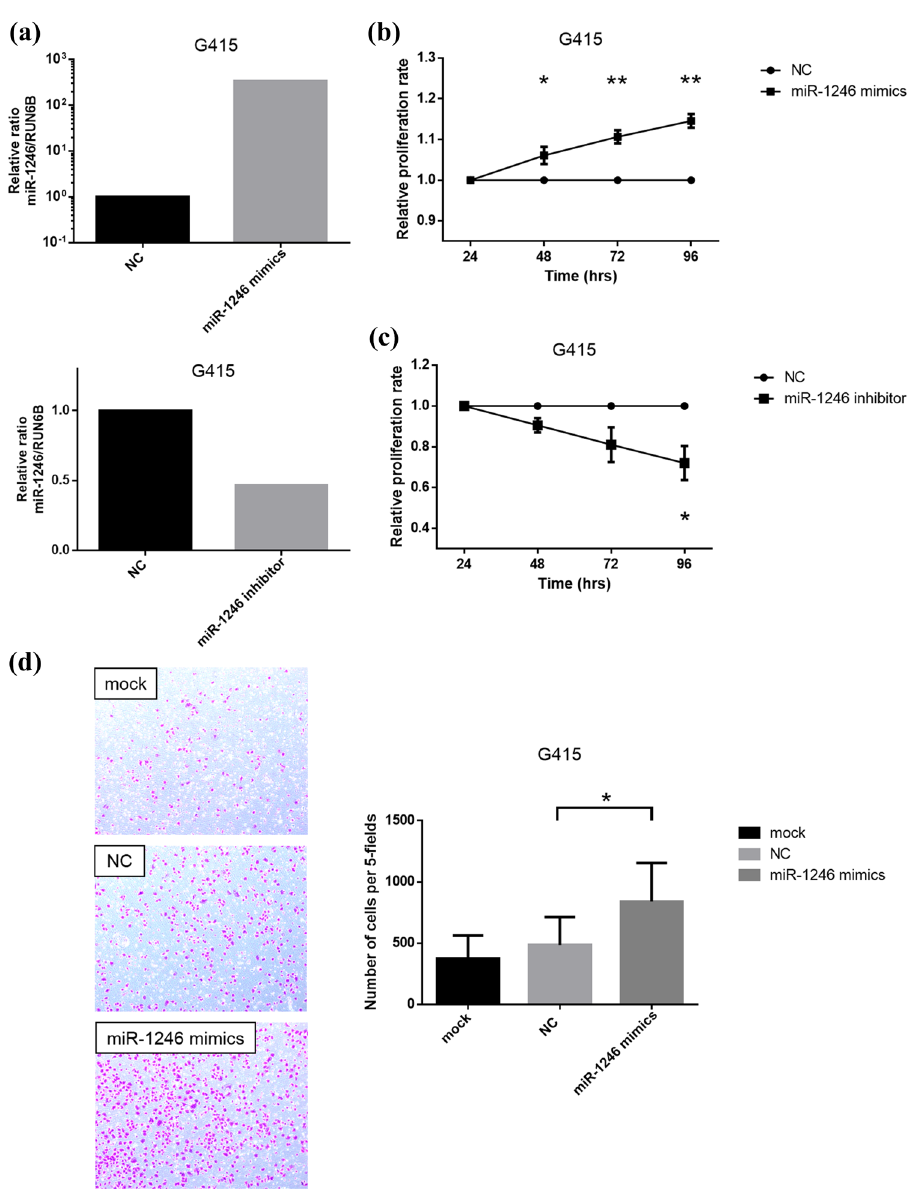
Figure 4. MiR-1246 promotes cell proliferation and invasion in gallbladder cancer cell lines. ( a ) Validation of the miR-1246 expression level after transfection of miR-1246 mimics, miR-1246 inhibitor and negative control in G415 cells was measured by RT-qPCR. The miRNA expression levels were normalized to the RNU6B expression. ( b ) The proliferation rate in G415 cells after transfection of 3 nM miR-1246 mimics or negative control was assessed by an MTT assay. The G415 cells showed significantly increased cell proliferation after the transfection of miR-1246 mimics. ( c ) The proliferation rate in G415 cells after the transfection of 100 nM miR- 1246 inhibitor or negative control was assessed by an MTT assay. The G415 cells showed significantly decreased cell proliferation after the transfection of miR-1246 inhibitor. ( d ) Cell motility after the transfection of 3 nM miR-1246 mimics, negative control or mock was assessed by a Transwell invasion assay. The numbers of invaded cells significantly increased upon transfection of miR-1246 mimics in comparison to negative control. Data are presented as mean ± s.e.m. * P < 0.05 and ** P <